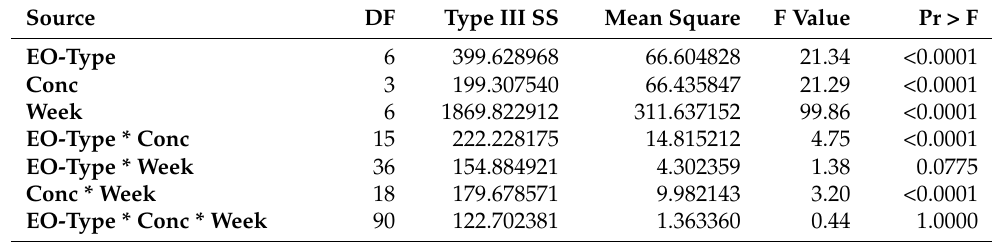
Table 1. Analysis of variance (ANOVA) of maize weevil mortality as affected by the type of EO (EO-Type), concentration of EO (Conc) and storage time (Week).